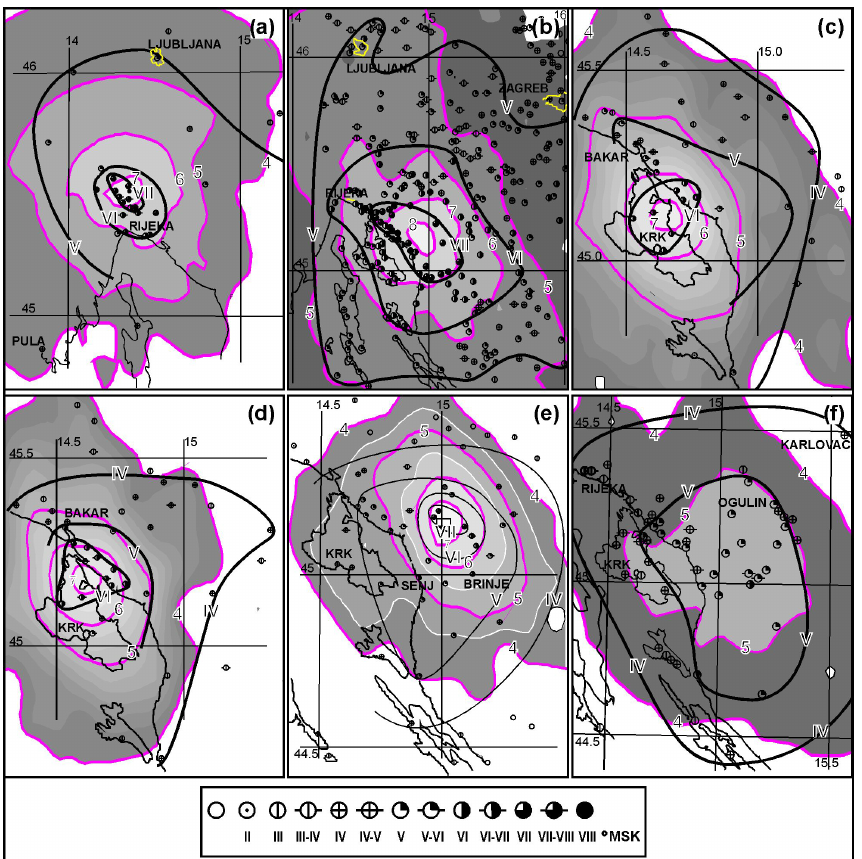
Figure 8. Empirical (black lines) and modelled (purple lines) isoseismal maps for the earthquakes that occurred on (a) 1 March 1870 at 19:57UTC, (b) 12 March 1913 at 03:23UTC, (c) 5 February 1939 at 22:00UTC, (d) 6 February 1939 at 07:23UTC; (e) 5 February 2007 at 08:30UTC and (f) 30 July 2013 at